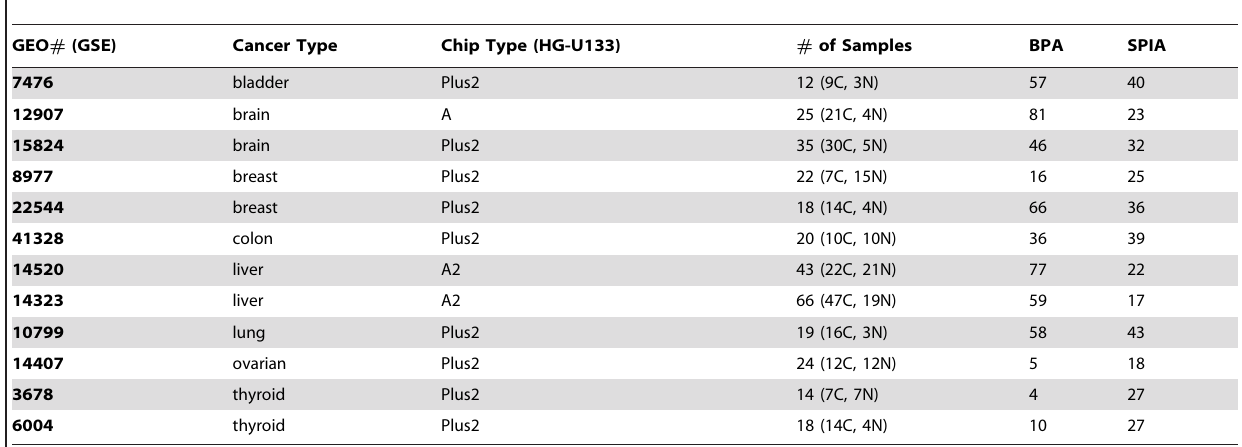
Table 3. Cancer Data Sets and numbers of active pathways Identified by BPA and SPIA analyses.